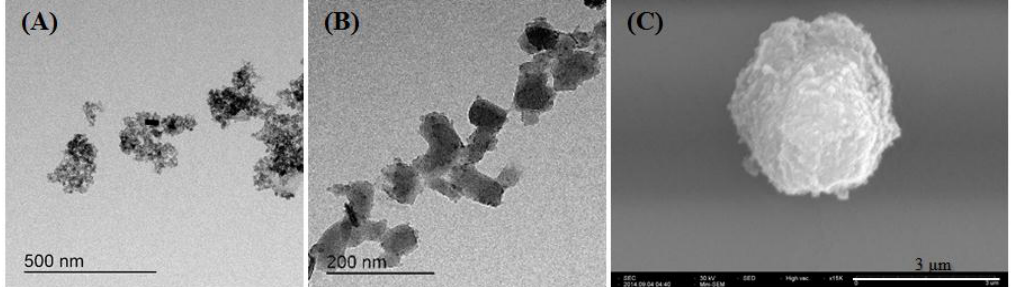
Figure 2. Electron microscope images. ( A ) Transmission electron microscopy (TEM) image of PDDA-coated iron oxide; ( B ) TEM image of Prussian blue; ( C ) Scanning electron microscopy (SEM) image of Prussian blue-coated PDDA@Iron